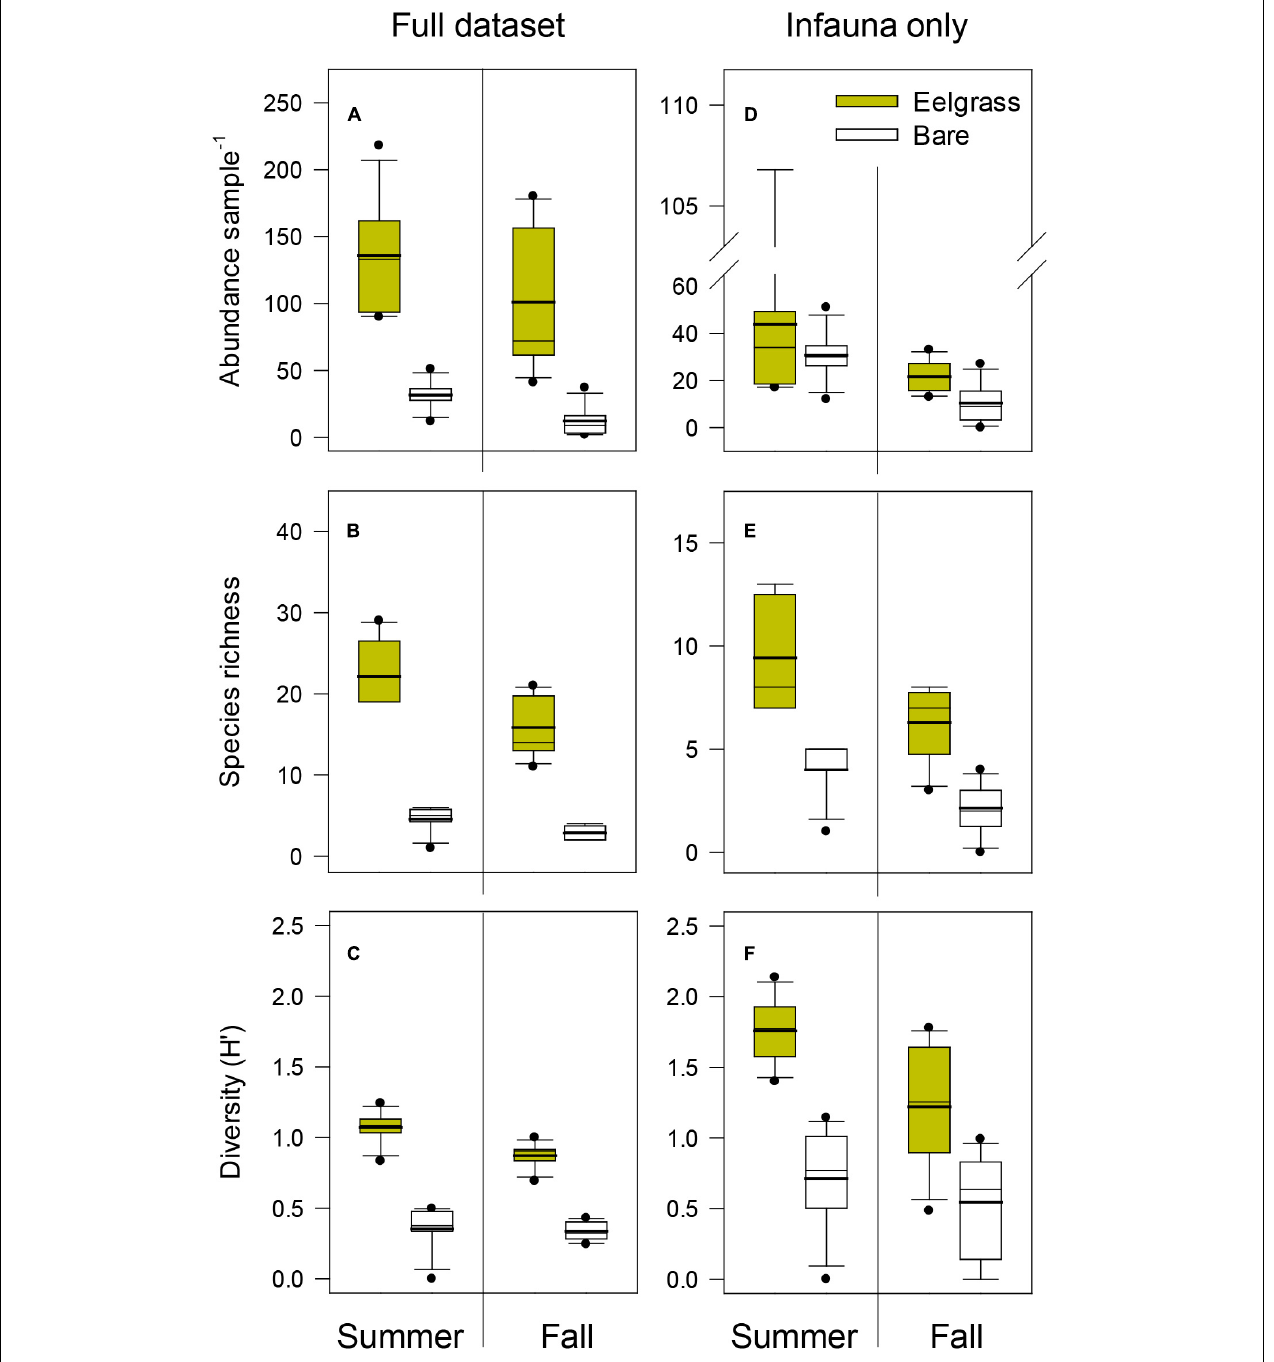
FIGURE 2 | Boxplots illustrating abundance, species richness and Shannon-Wiener diversity of communities associated with eelgrass and bare sediment habitats during the 2010 summer and fall surveys. A distinction is made between results obtained from the full dataset (A–C) and a subset including infaunal species only (D–F) . Mean values (thick black lines) are included in the boxplots. Between-habitat differences were significant (Mann-Whitney U Statistic’s p < 0.05) in all 12 comparisons except in the abundance of infauna during the summer (D; p > 0.05).